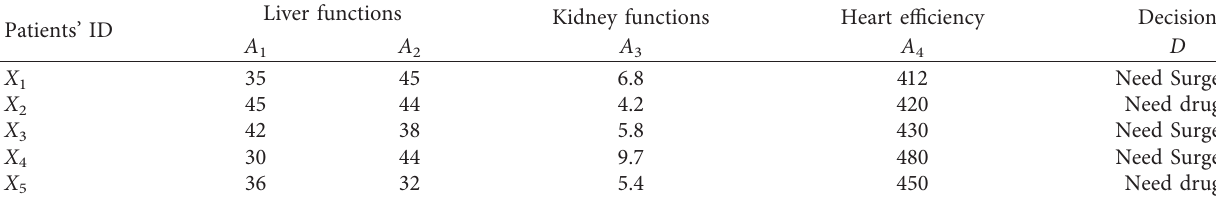
Table 2: The infection information system of